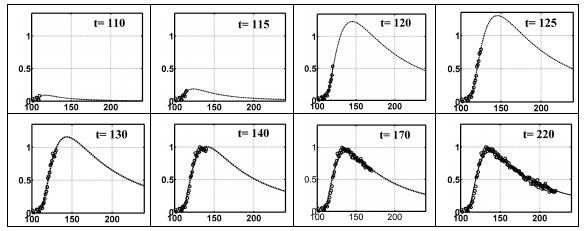
Fig. 2. Fig. 2. Calculation on line parameters β , K 1 (R) , and N o (R) and forecasting of total neutron intensity (time t is in minutes af- ter 10:00 UT on 29 September 1989; curves – forecasting, circles – observed total neutron intensity).